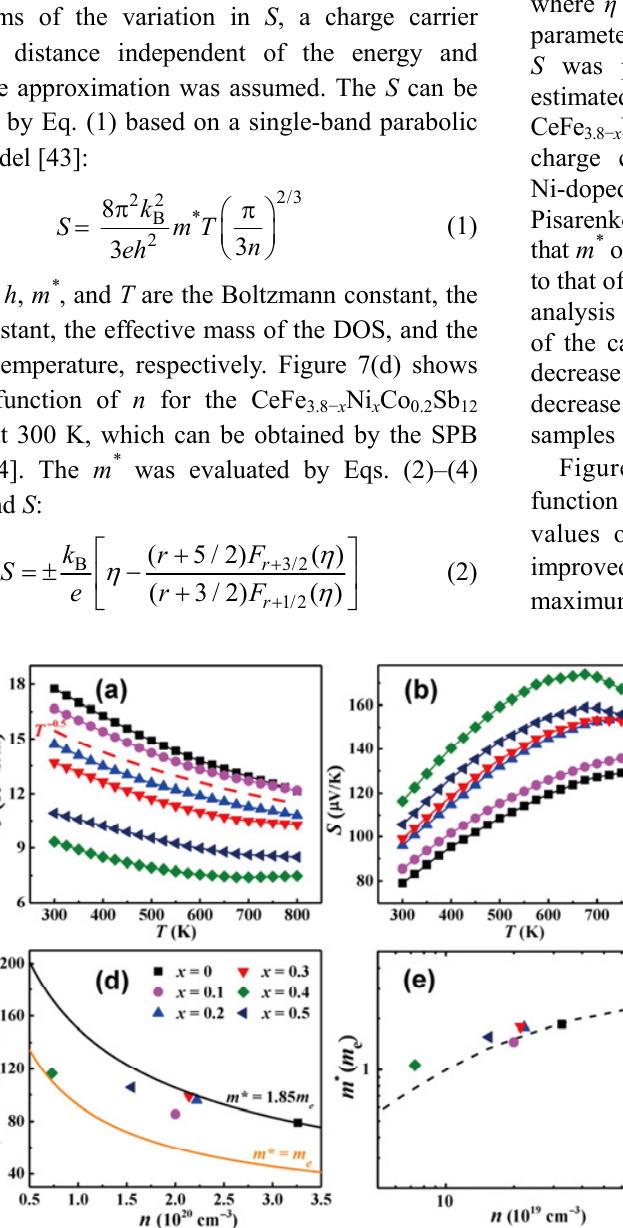
Fig. 7 (a) Electrical conductivity and (b) Seebeck coefficient as a function of temperature for CeFe 3.8 − x Ni x Co 0.2 Sb 12 samples at temperatures of 300–800 K. (c) Hall mobility as a function of carrier concentration for CeFe 3.8 − x Ni x Co 0.2 Sb 12 samples. (d) Curves